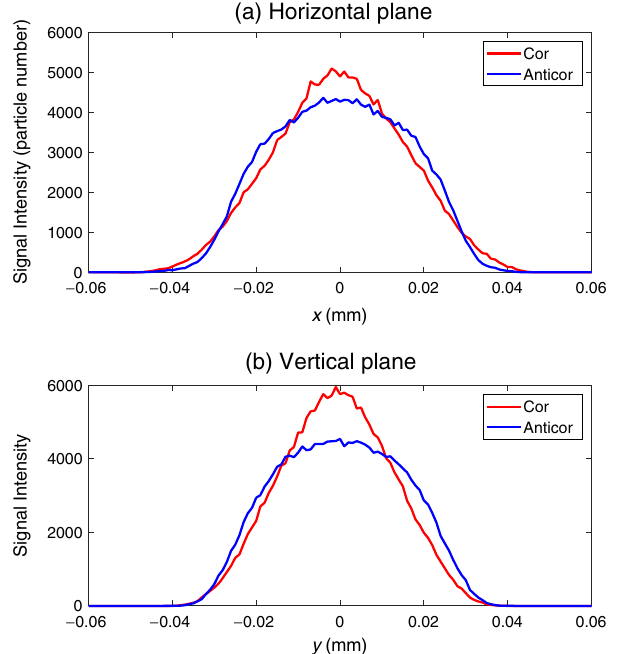
FIG. 8. Comparison of the transverse beam distributions for the correlated and anticorrelated painting in the simulation under the same conditions. Subgraph (a): horizontal beam distributions; subgraph (b): vertical beam distributions.